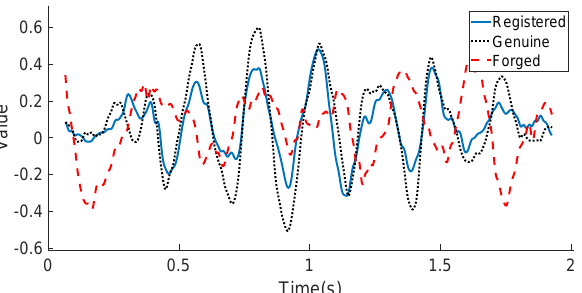
Figure 10. User’s motion sensor data example (Acceleration-Y): registered, genuine, and forged in-air signatures.